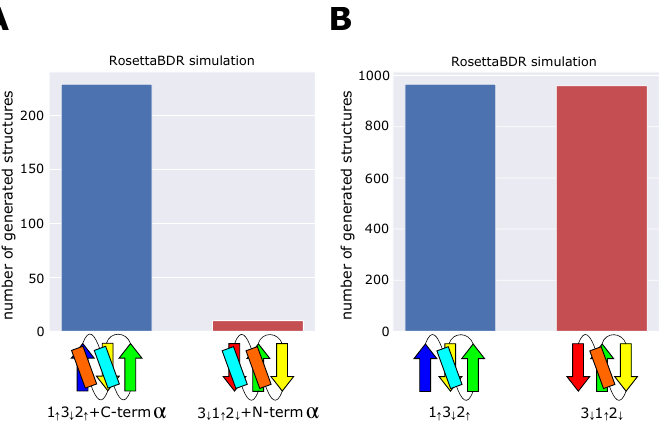
Figure 3. The number of simulated structures compatible with the blueprint. We repeated the Rosetta folding simulations 10,000 times and counted the number of compatible structures generated. ( A ) Comparison between the 1 ↑ 3 ↓ 2 ↑ + C-term α topology and the 3 ↓ 1 ↑ 2 ↓ + N-term α topology. In simulations, the number of structures in which two helices lie on the same side of the β -sheet surface was counted. ( B ) Comparison between the 1 ↑ 3 ↓ 2 ↑ topology and the 3 ↓ 1 ↑ 2 ↓